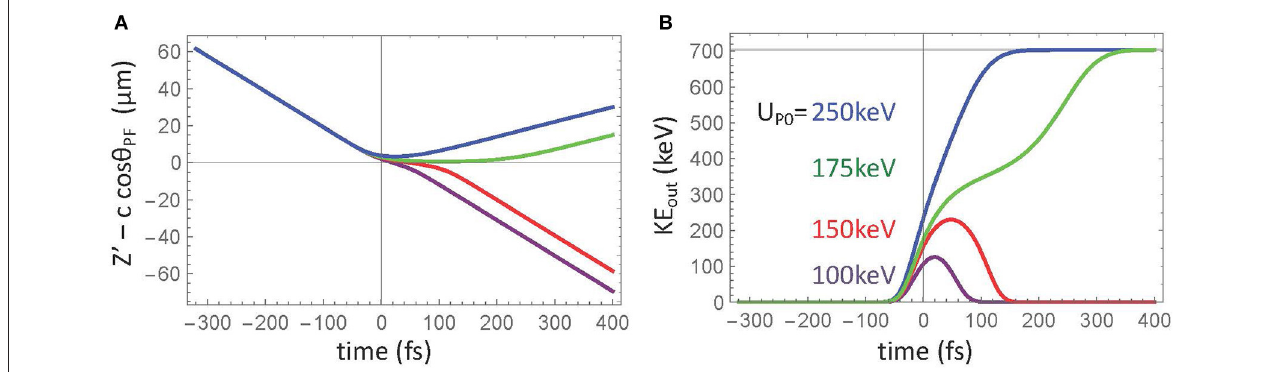
FIGURE 2 | Relativistic calculations of acceleration in the moving frame for a pulse front angle of 50 ◦ , for which the non-relativistic capture potential is U cap 0 P = 100 keV . The electron is initially at rest in the lab frame. The different curves correspond to varying values of the peak ponderomotive potential. (A) Electron trajectories and (B) kinetic energy. The horizontal gray line in (B) represents 4x the calculated threshold for capture.